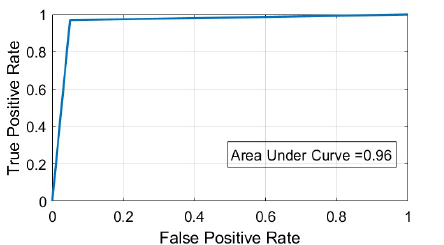
Figure 10. The Receiver Operating Characteristic (ROC) curve of SECOD.